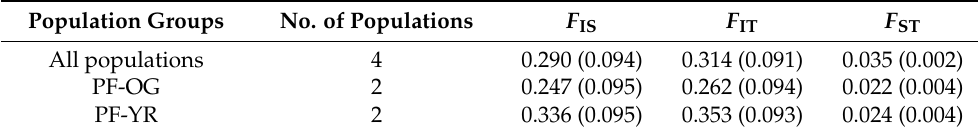
Table 5. Group-wise mean (SE) F -statistics estimates from 10 microsatellites loci.